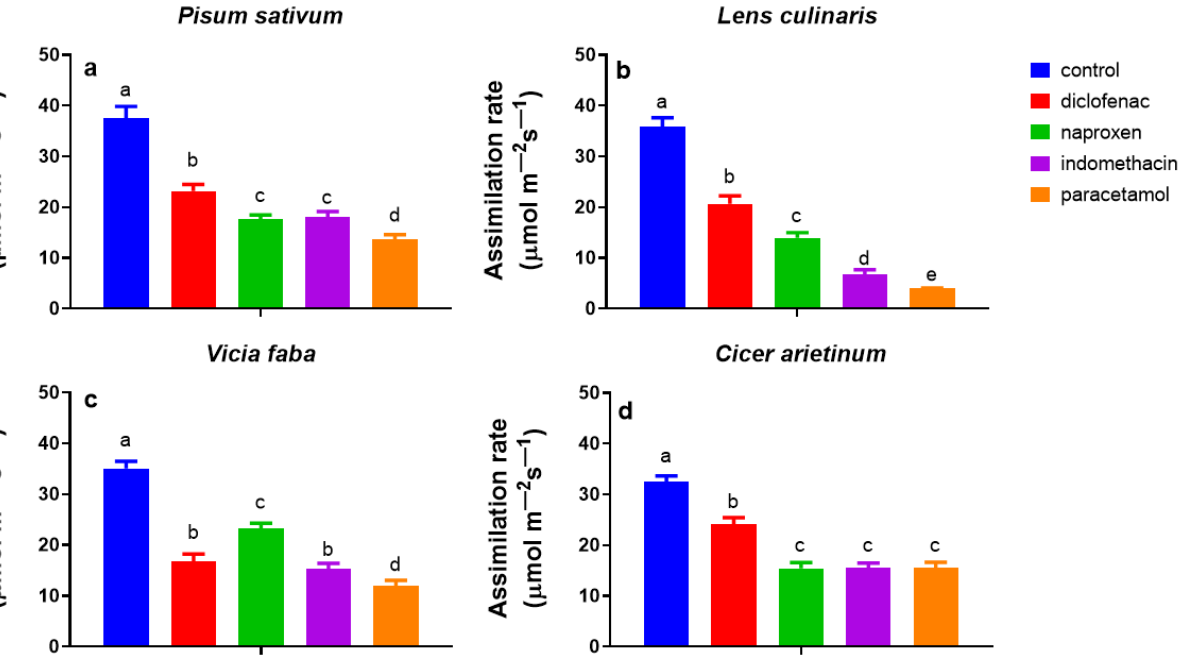
Figure 1. The assimilation rate from Pisum sativum ( a ), Lens culinaris ( b ), Vicia faba ( c ), and Cicer arietinum ( d ). Plants in 0.5 L pots filled with commercial garden soil were treated by watering 100 mL of 0.5 mg L − 1 NSAIDs every second day over a total of 20 days. The values are averages of four independent measurements. Data sharing different letters are significantly different ( p < 0.05), while data sharing the same letters are not significantly different ( p > 0.05).